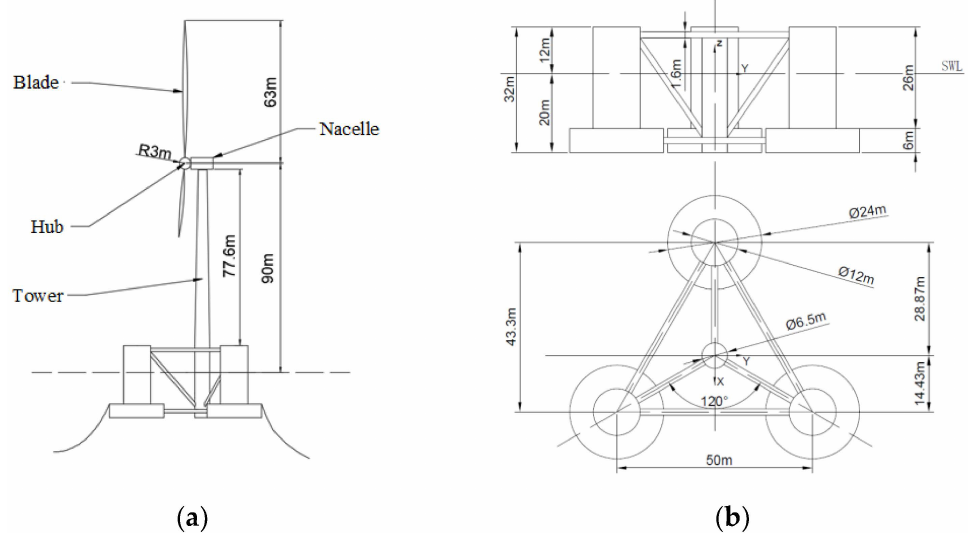
Figure 1. Overall dimension drawing of wind turbine: ( a ) Dimension drawing of OC4-DeepCwind wind turbine; ( b ) Parameter of OC4-DeepCwind dimension drawing of semi-submersible platform.